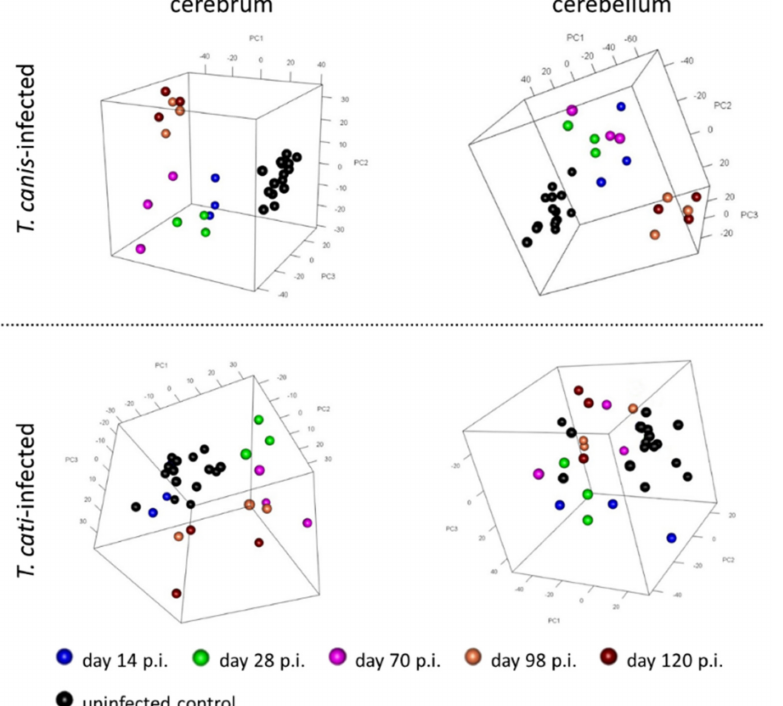
Figure 1. Principal component analysis of transcriptional changes in cerebra and cerebella of T. canis - and T. cati -infected C57Bl/6J mice at different time points post-infection. To provide a better overview, all respective control mice are shown in black.